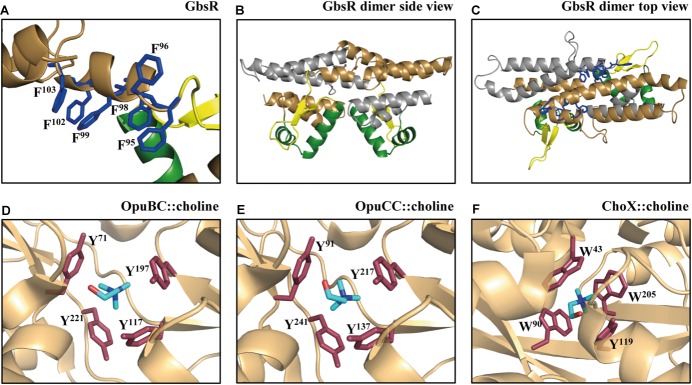
Structural comparison of the choline-binding pockets present in the OpuBC, OpuCC, ChoX substrate-binding proteins with the in silico predicted inducer-binding site of the B. subtilis GbsR repressor. (A)
In silico model of the monomer of the B. subtilis GbsR protein (Nau-Wagner et al., 2012); it is based on the crystal structure of the DNA-binding protein Mj223 of M. jannaschii (PDB entry 1KU9) (Ray et al., 2003). (B,C) A side and top view, respectively, of the in silico predicted GbsR dimer. The winged helix-turn-helix region is represented in green, the inter-domain linker region is shown in yellow, and the six aromatic amino acids potentially involved in structuring the inducer-binding site are highlighted in blue. Crystal structures of (D) the B. subtilis OpuBC protein (PDB entry 3R6U; Pittelkow et al., 2011), (E) the B. subtilis OpuCC protein (PDB entry 9PPQ; Du et al., 2011), and (F) the Sinorhizobium meliloti ChoX protein (PDB entry 2REG; Oswald et al., 2008) all in complex with a choline molecule (blue sticks) are depicted. Aromatic amino acids involved in choline binding are highlighted in red.